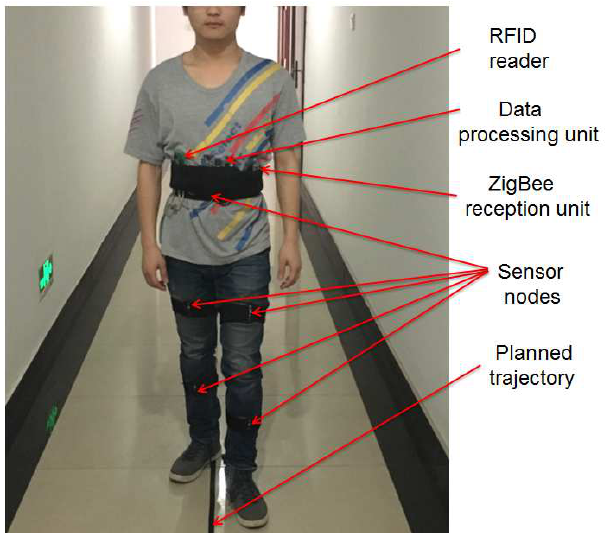
Figure 15. Wearable sensor system for posture recognition and indoor localization.